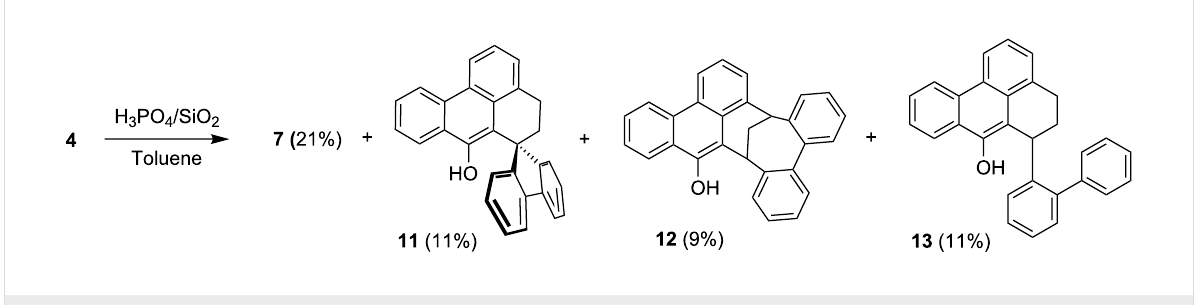
Scheme 3: Conversion of the enol 4 under acidic conditions and reaction products.